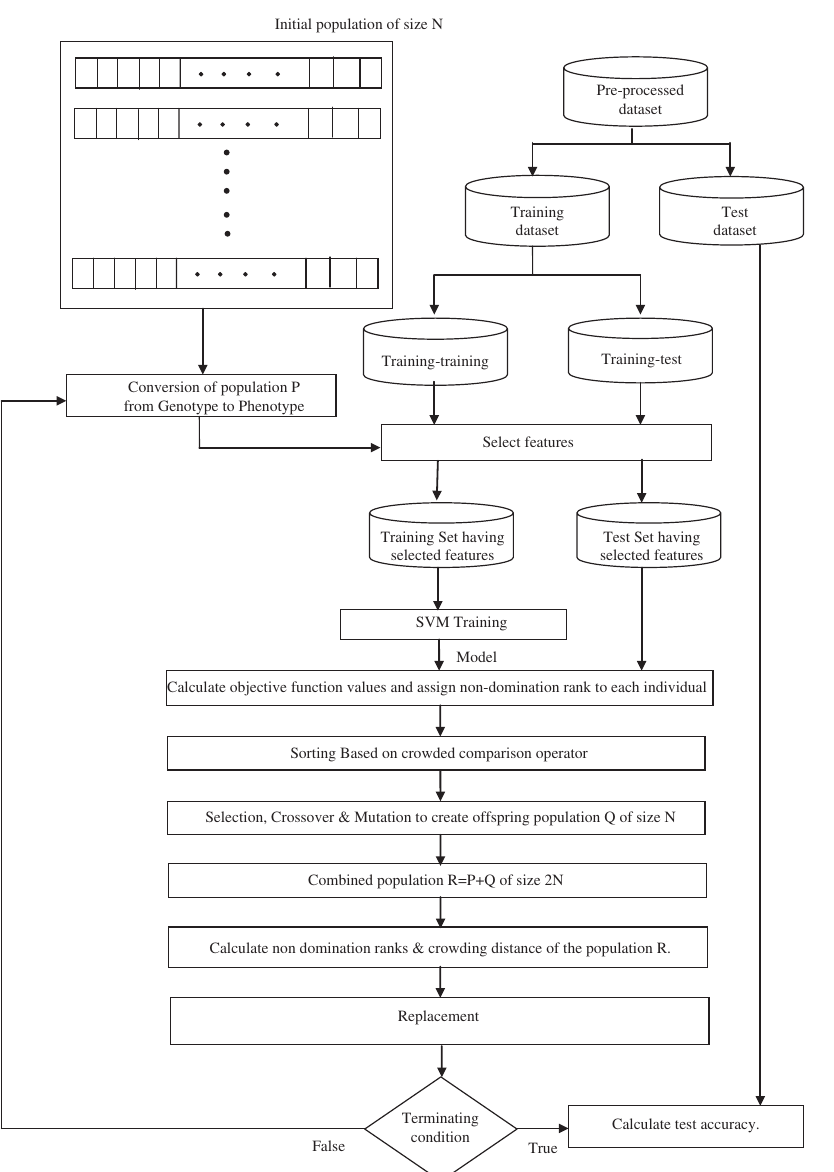
Reproduction of population: The binary tournament selection, recombination, and mutation operators are applied to population P of size N to create first offspring population Q of size N . Rank and crowding distance calculation: Non-domination ranks and the crowding distance of the com- bined population are calculated. This new combined population R is sorted according to the crowed comparison